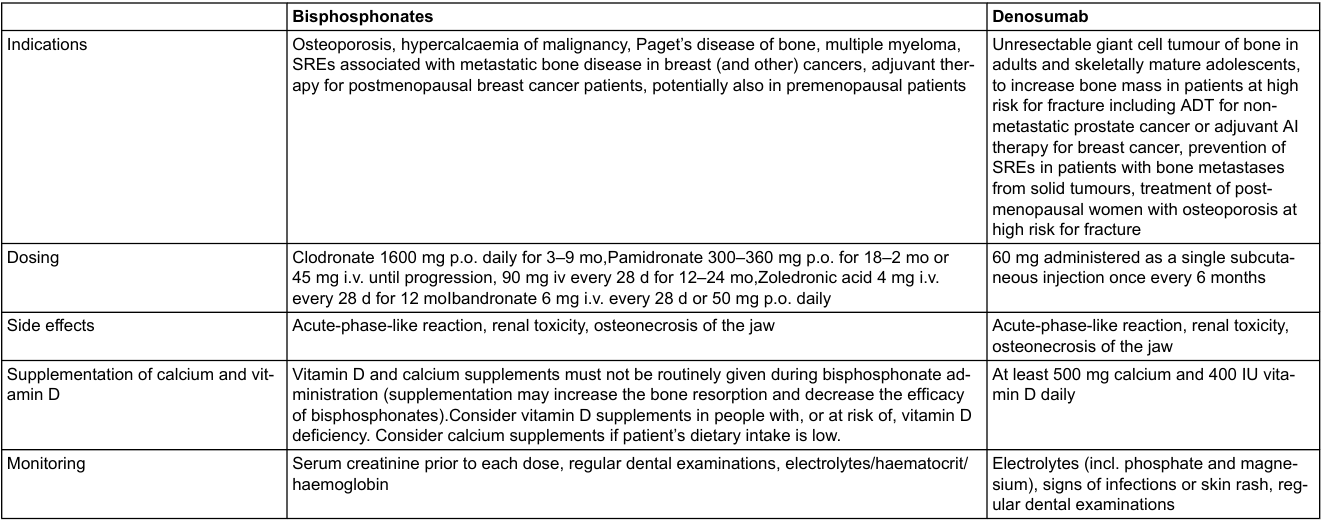
Table 1: Denosumab and bisphosphonates at a glance. Bisphosphonates Denosumab Indications Osteoporosis, hypercalcaemia of malignancy, Paget’s disease of bone, multiple myeloma, SREs associated with metastatic bone disease in breast (and other) cancers, adjuvant ther- apy for postmenopausal breast cancer patients, potentially also in premenopausal patients